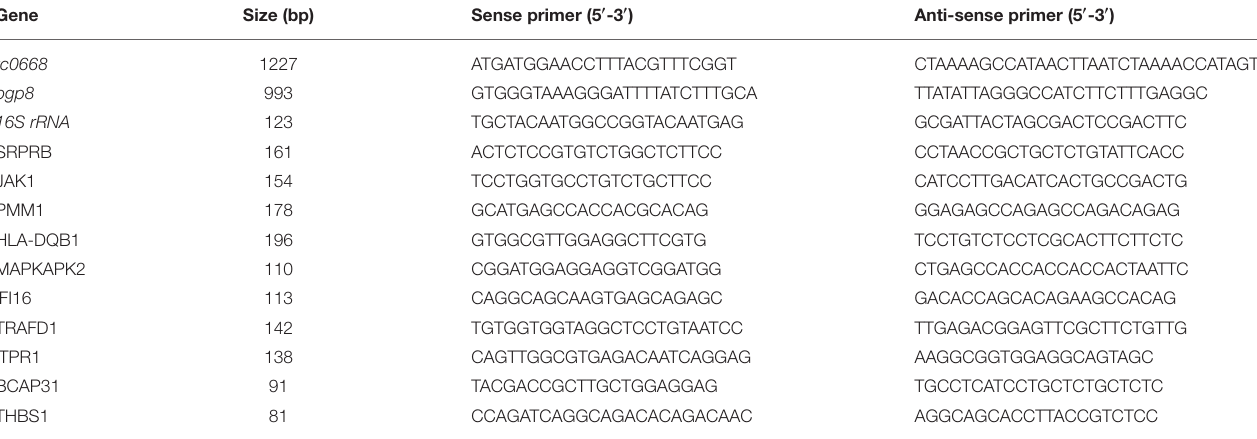
TABLE 1 | Primer sequences for